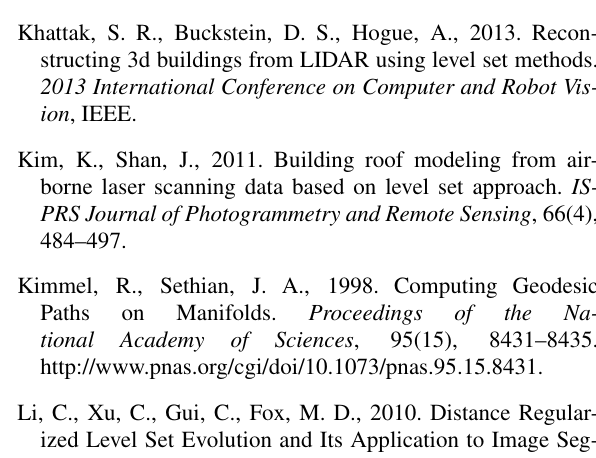
Figure 7. Gullies and sinkholes in flat terrain. a) Hillshade created from a rasterised airborne laser scan, interpolated at 0.25 m; b) saliency map (point cloud): lighter colours represent higher saliency